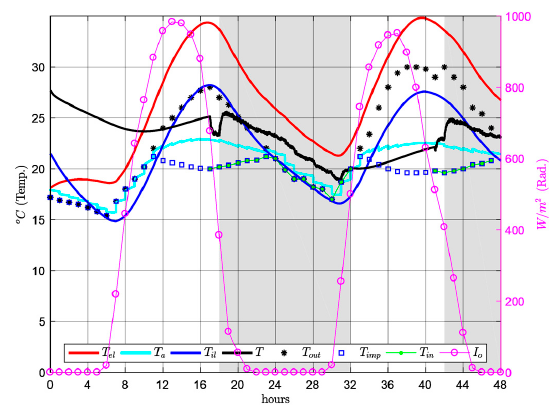
Figure 14. Case 2: Efficient energy proposal. Summer with free cooling. Data: calculated temperatures: T el , T a , T il , T at a height of 1.5 m, outdoor temperature T out , impulse temperature T imp , inlet temperature T in , all of them against the left y -axis and radiation I o against the right y -axis.